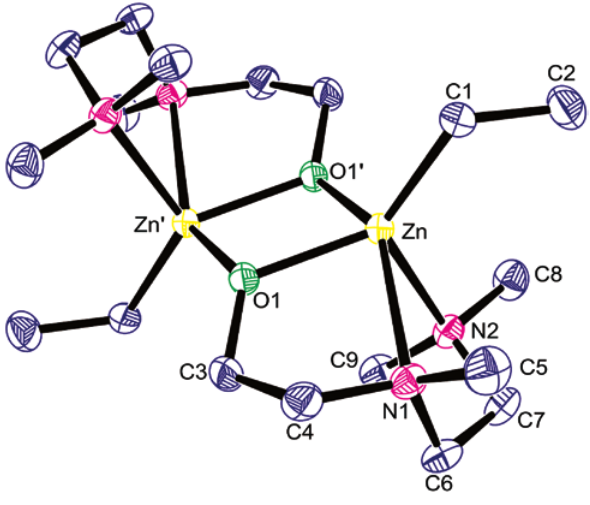
Figure 3: The asymmetric unit of 3 showing the labelling scheme used; thermal ellipsoids are at the 50% probability level. Selected geometric data: Zn-O(1) 1.9916(9), Zn-O(1 ′ ) 2.1085(10), Zn-N(1)